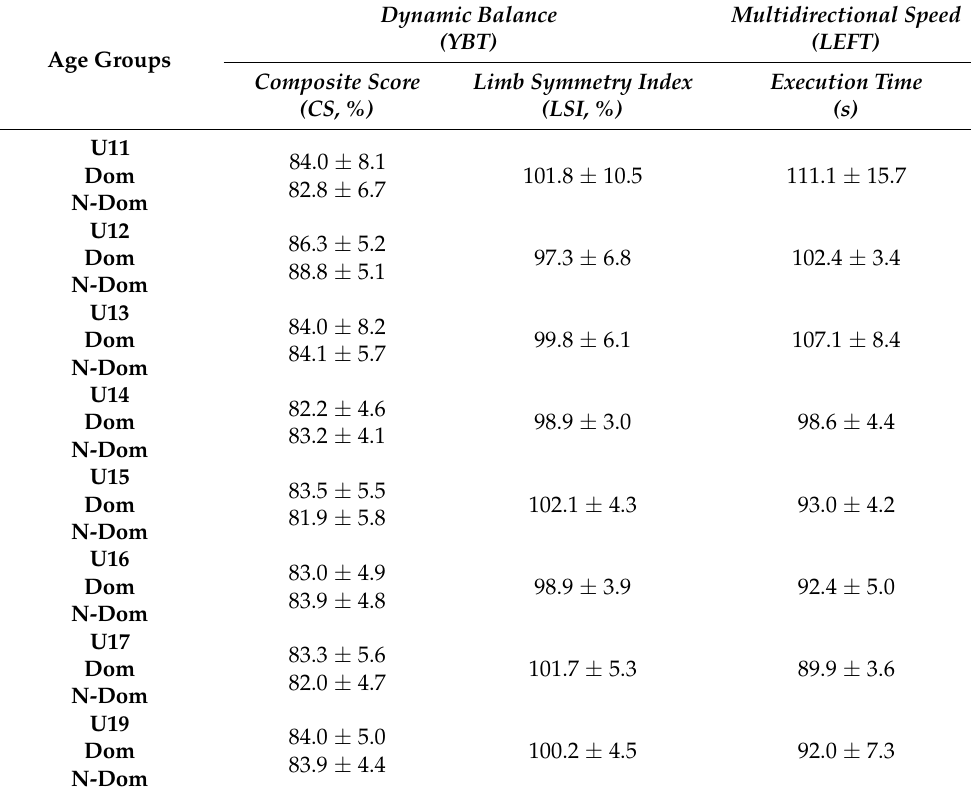
Table 2. Descriptive statistics of the functional performance tests (Mean ± SD). Age Groups